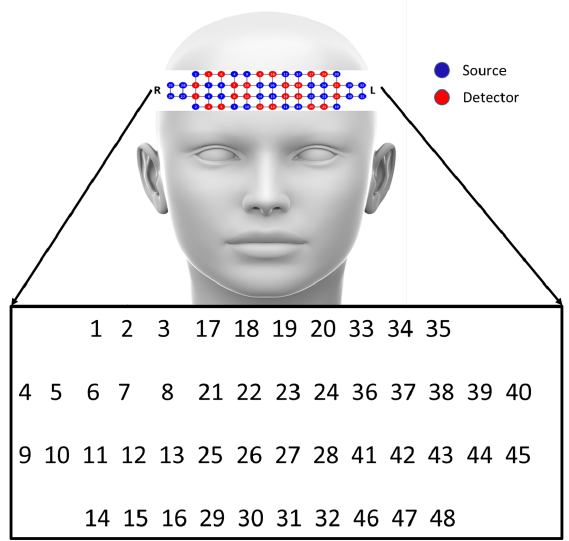
Figure 2. Nirsit Device Channel Locations at 30 mm